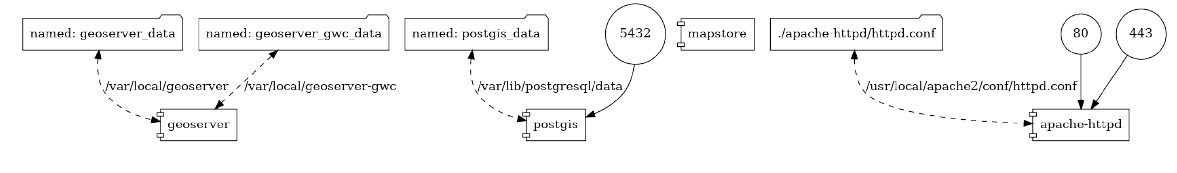
Figure 11. eMOTIONAL Cities Legacy stack docker-compose